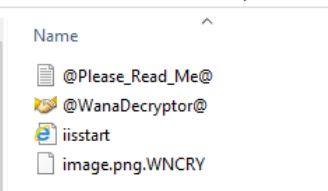
Figure 5. IIS root directory under WannaCry’s infection.